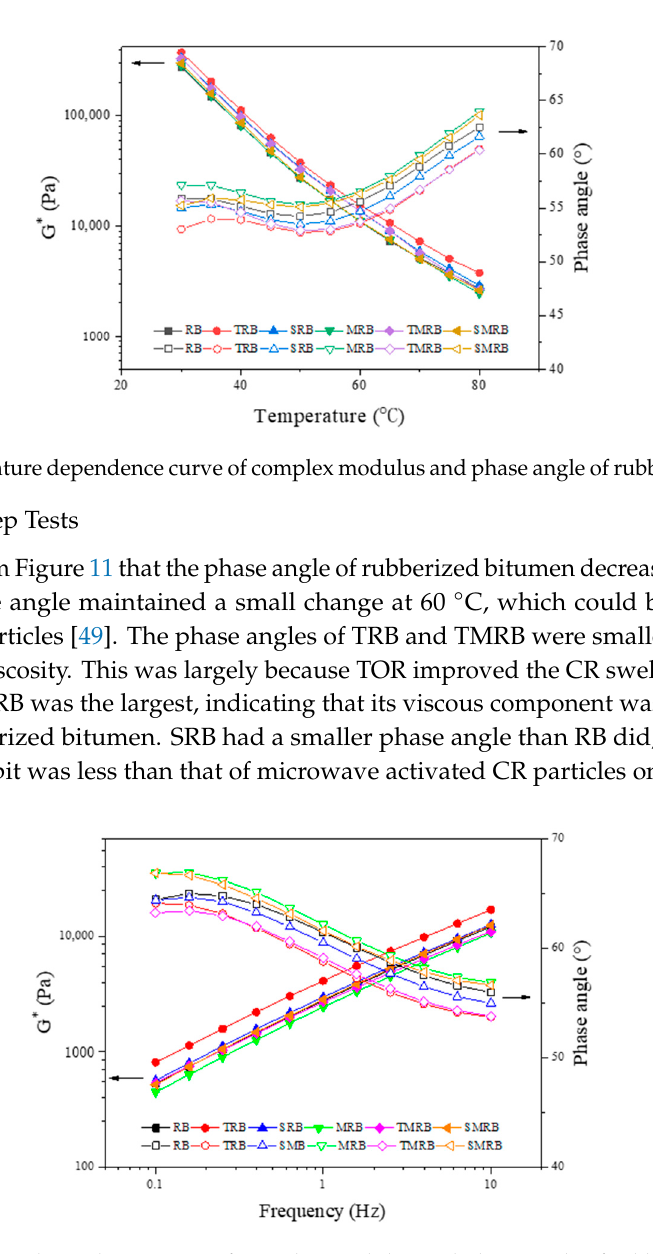
Figure 11. Frequency dependence curve of complex modulus and phase angle of rubberized bitumen.